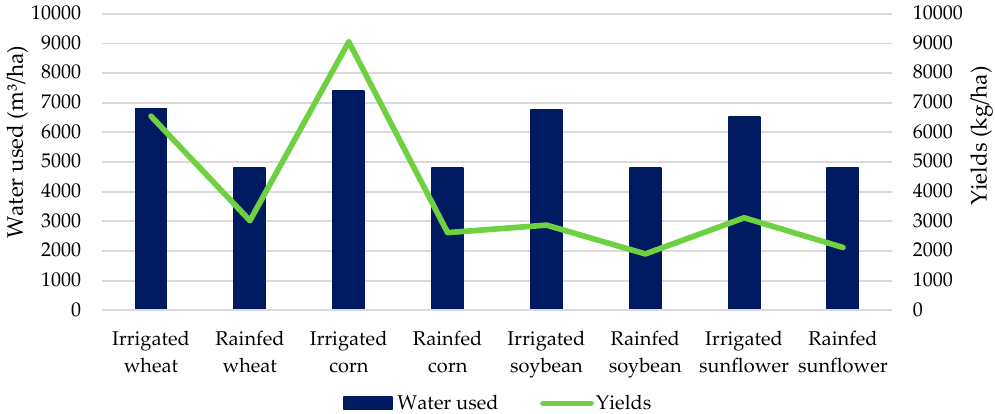
Figure 15. Yields and water used of irrigated and rainfed agriculture, 2017–2018 crop season, SCDA Br ă ila farm.